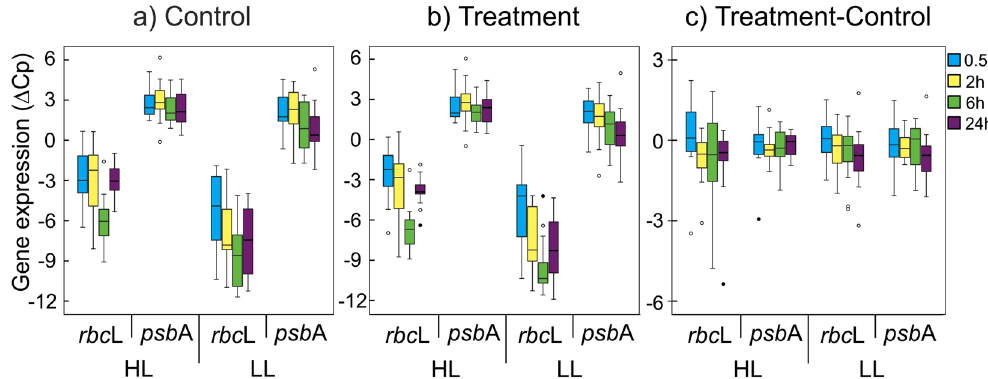
Figure 2. Expression time course of the photosynthetic rbc L and psb A genes. Expression of both target genes was measured for HL and LL Prochlorococcus separately in every sample of each experiment. This figure shows the time course of each gene in ( a ) control (no-treated) samples, ( b ) treatments (treated with any of the pollutant mixtures), and ( c ) the differential expression between treatments and controls. p values associated to the different gene expression data distributions (Kruskal-Wallis) are indicated. n/s, non-significant (p >